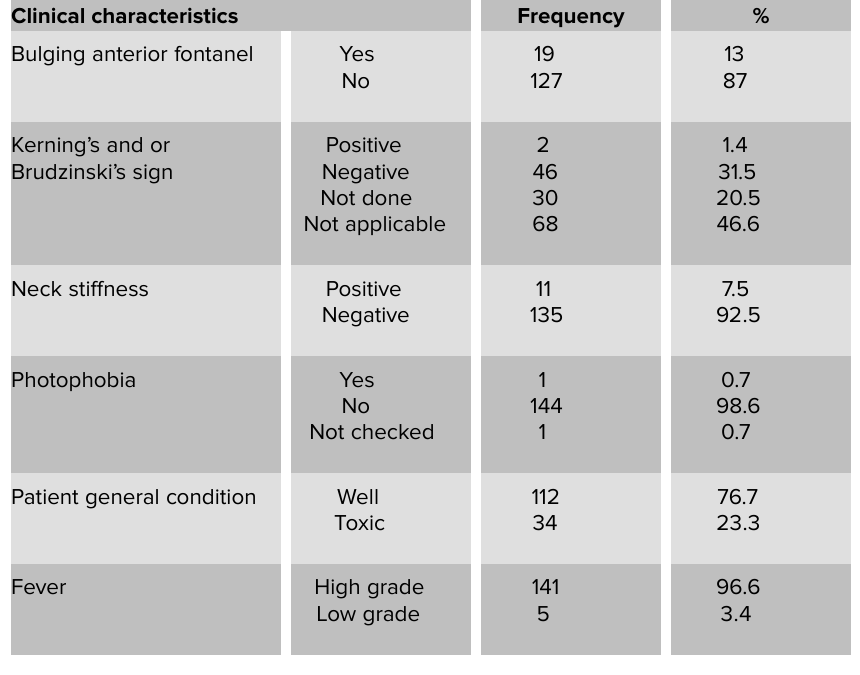
Table 4: Distribution of the study population according to clinical characteristics